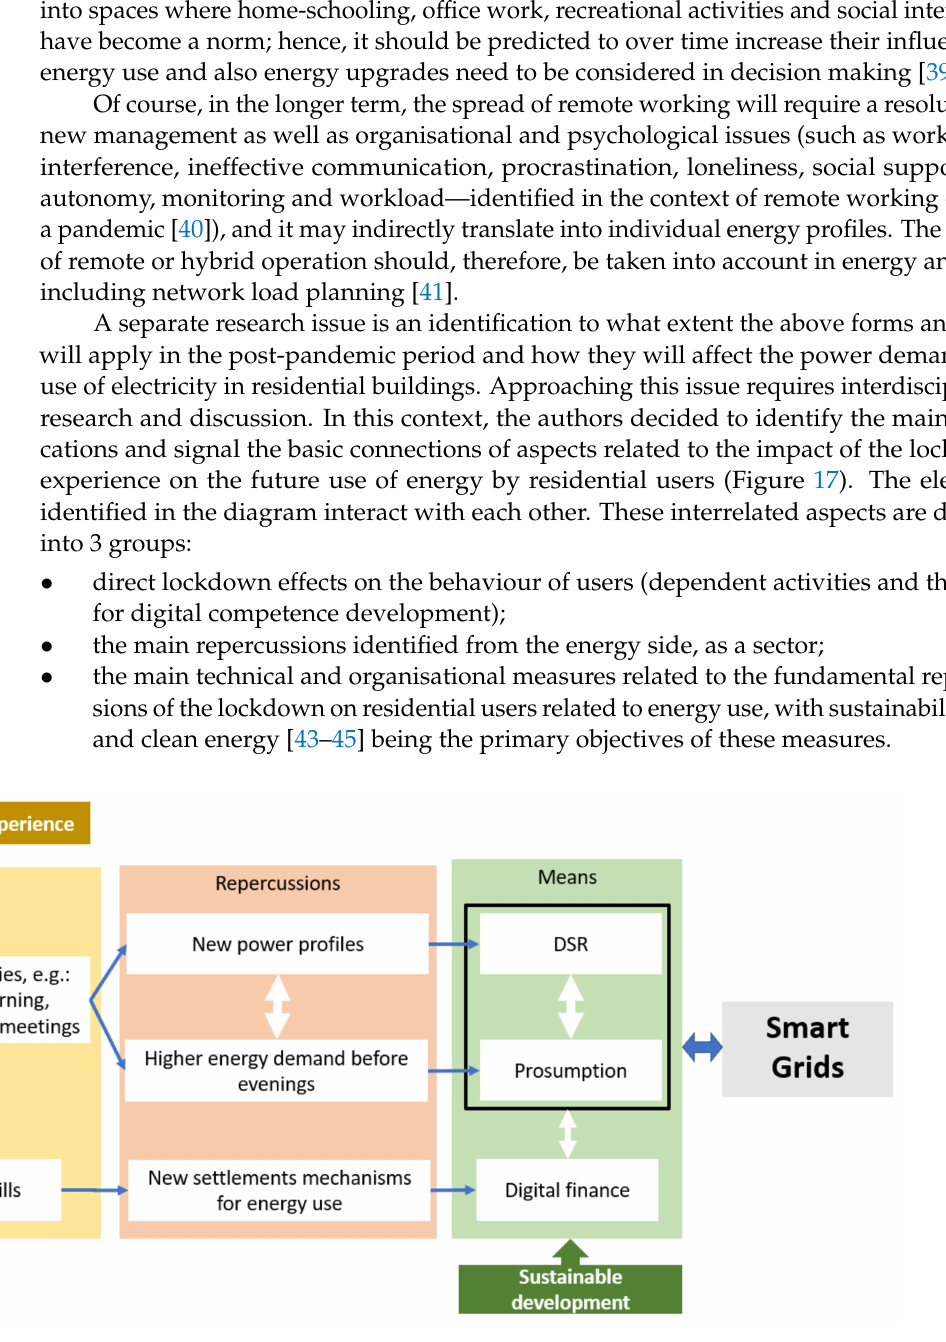
Figure 17. Links between the aspects identified in the article related to lockdown experiences in the context of electricity use in